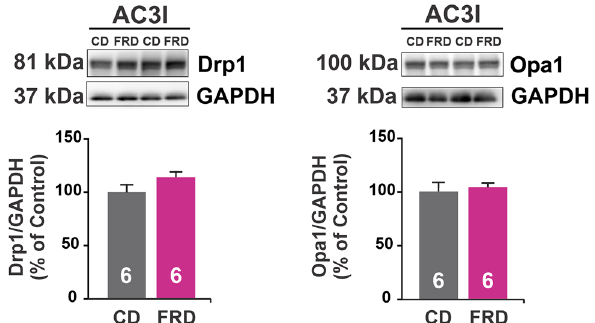
Figure 9. Cardiac CaMKII inhibition precludes unbalanced dynamics induced by prediabetes. Representative immunoblots of Drp1 and Opa1, fission and fusion proteins, respectively, and average bar graphs. FRD